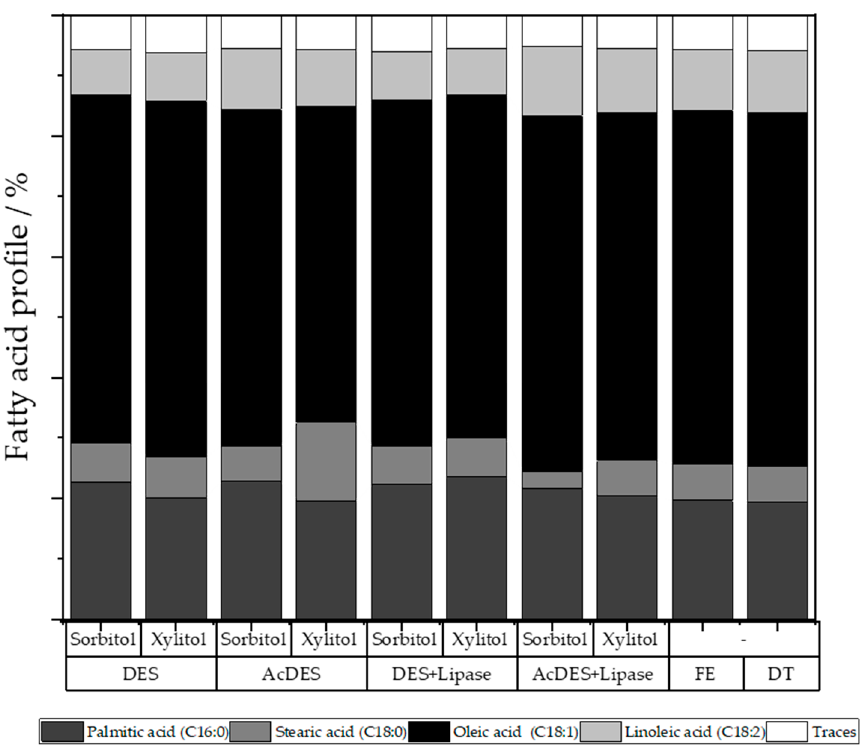
Figure 5. Distribution of fatty acids for the extraction carried out by microwave with different sugar alcohol-based DES conditions, the Folch extraction process (FE), and the direct transesterification (DT) on the oily biomass.